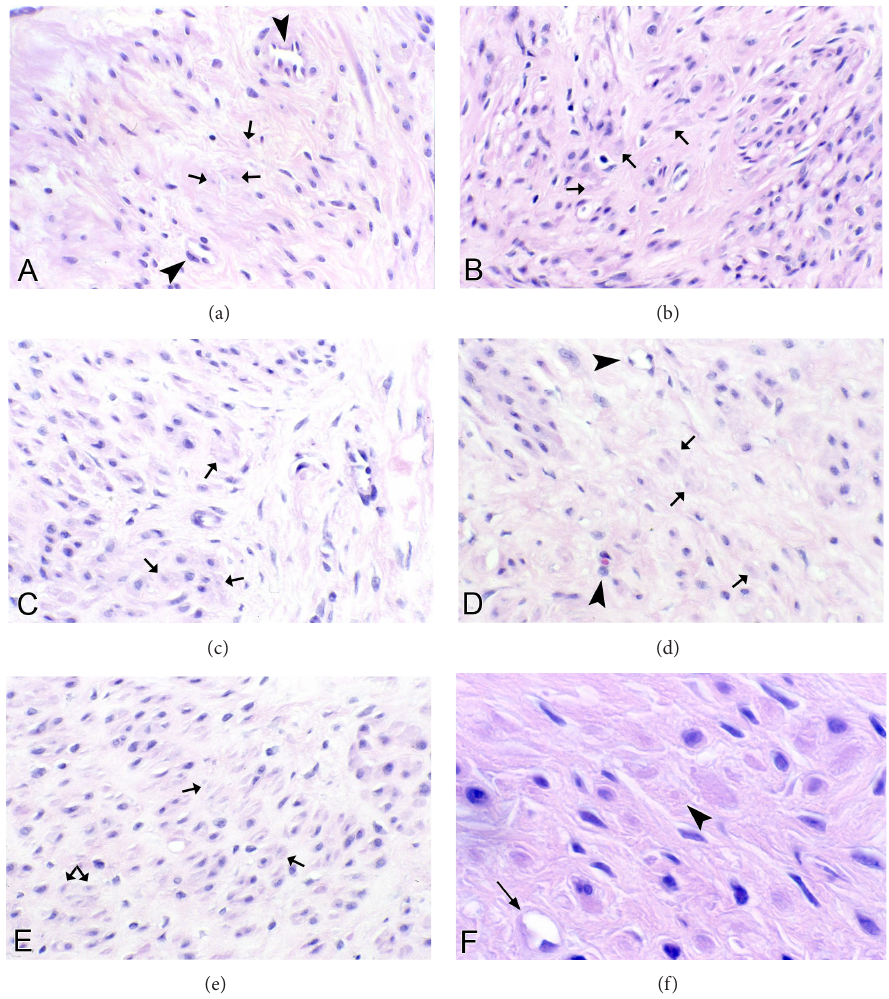
Figure 15: Inanosis of tumor myocytes. Interstitial and vascular ischemia lead to myocyte atrophy and eventual cell death, a process that we refer to as inanosis. In this panel, each image shows cytoplasmic and nuclear atrophy of tumor myocytes, as well as scattered, shrunken cells with marked nuclear pallor that are probably nonviable (arrows in (a)–(e)). In addition to those marked by arrows, there are other similar pale, presumably nonviable cells scattered among the viable cells with blue nuclei, resulting in a mottled pattern. Note the absence of inflammatory reaction. (a) The pale, inanotic cells are widely separated from the capillary at the top and the capillary at the bottom (arrowheads). (b) The pale, presumably dead cells are scattered among atrophic, but viable, cells with dark blue nuclei. (c) The pale, inanotic cells are shrunken but usually maintain elongate shapes. (d) Note that the pale, inanotic cells in the center are the most distant cells from the capillary with the open lumen at the top and the apparent capillary with a red cell in the lumen at the bottom (arrowheads). (e) Pale cells are noted here and there among the atrophic, viable cells in a field without any obvious capillaries. No inflammation is present. Original magnification of photos ((a)–(e)): 132x. (f) Oil immersion image of inanotic cells (myocyte tombstones) with pale nuclei and cytoplasm, in a fibrotic, atrophic field of a Phase 3 tumor. The cell in the center of the field (arrowhead) is located 76 𝜇 m from the capillary in the left lower corner (arrow). Original magnification of (f):